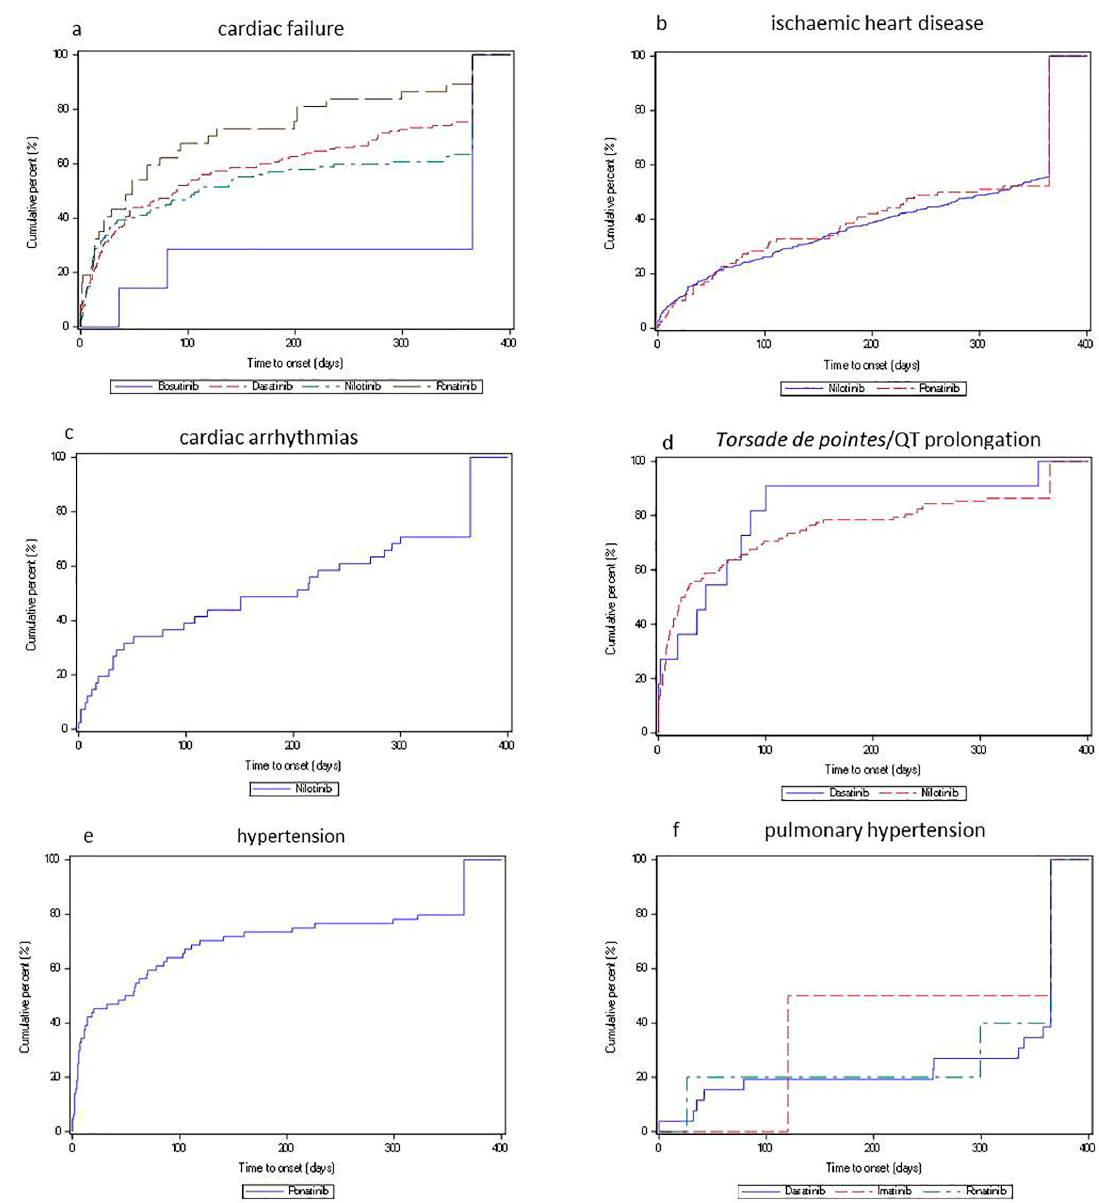
Figure 2. Cumulative distribution function of TKIs by time-to-onset.